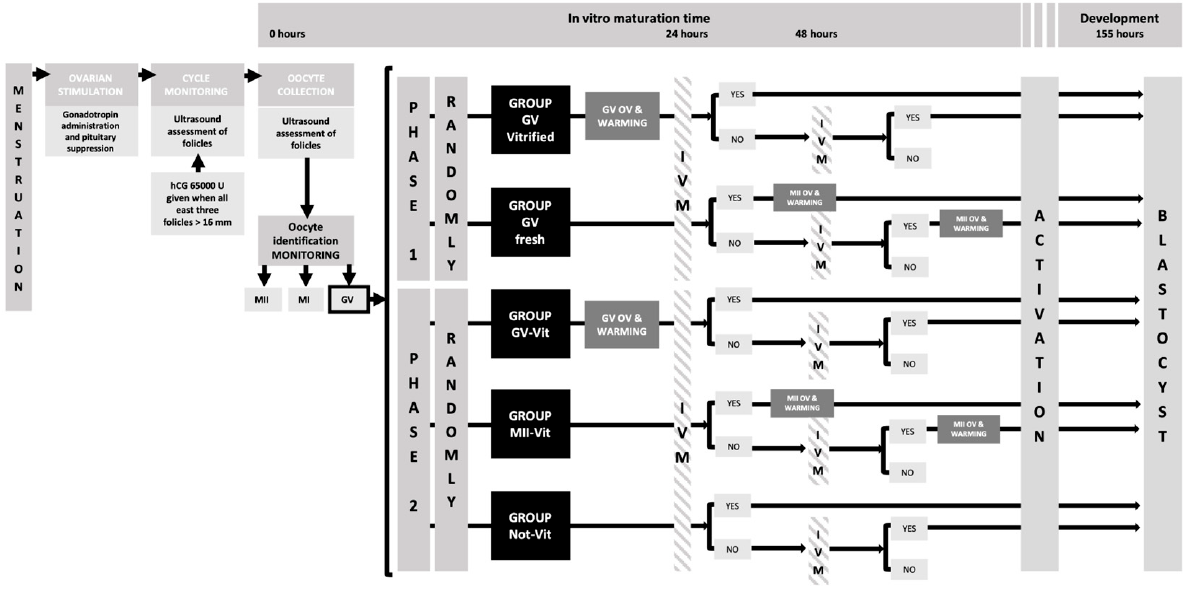
Figure 1. Experimental design describing the study groups and the methodology used, as well as the different in vitro maturation times (24 and 48 h): GV, prophase I; MI, metaphase I; MII, metaphase II; OV, oocytes vitrification; IVM, in vitro maturation.